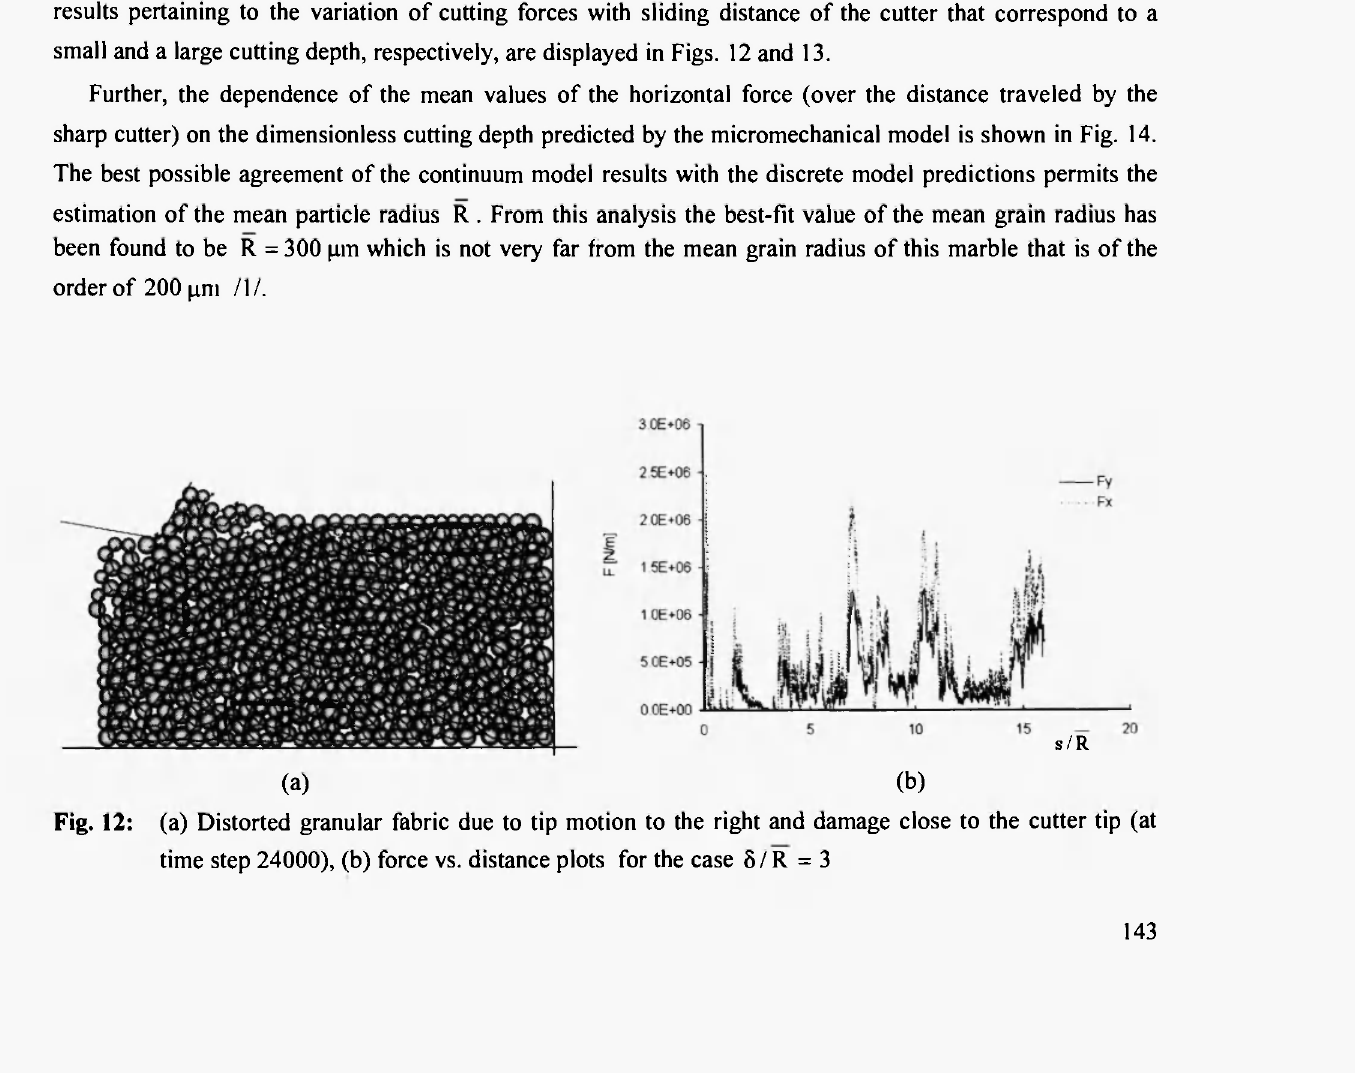
Lateral confining stress, σ 3 [Mpa] Fig. 11: Comparison of Dionysos marble triaxial test strength results and calibrated model predictions in principal stress (σ, σ 3 ) space